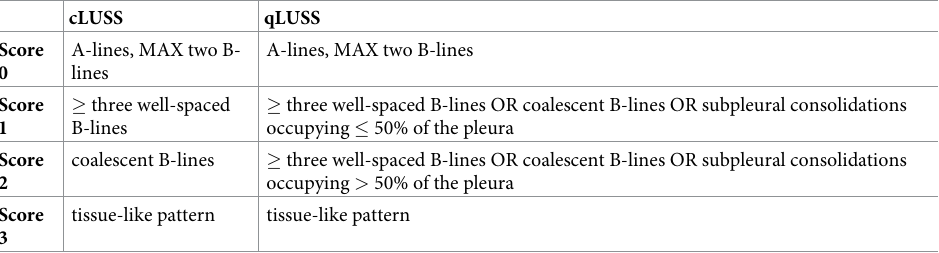
Table 2. Scoring protocol: cLUSS and